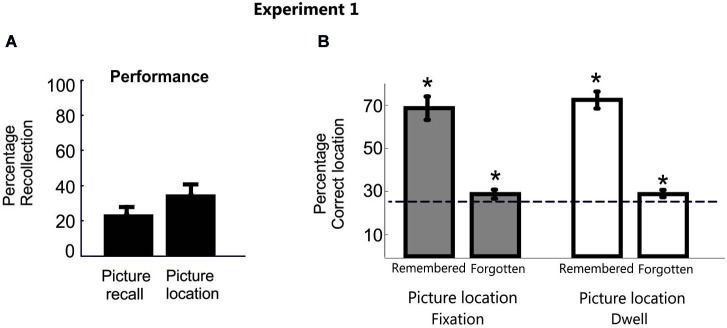
Behavioral data in Experiment 1. (A) Percentage of correct picture and location recall responses averaged across participants for Experiment 1. (B) Bar plots represent the proportion of fixation and dwell time in the correct picture location averaged across participants in Experiment 1. Error bars denote Standard Error of the Mean. * p < 0.05; “n.s.” denotes p > 0.05.